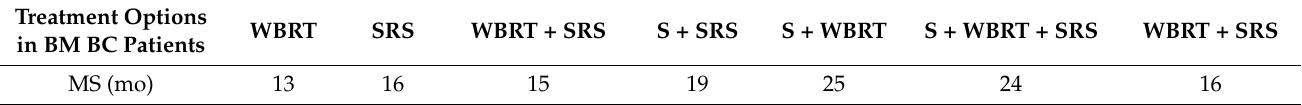
Table 4. Median survival (MS) of brain metastatic breast cancer patients, including various